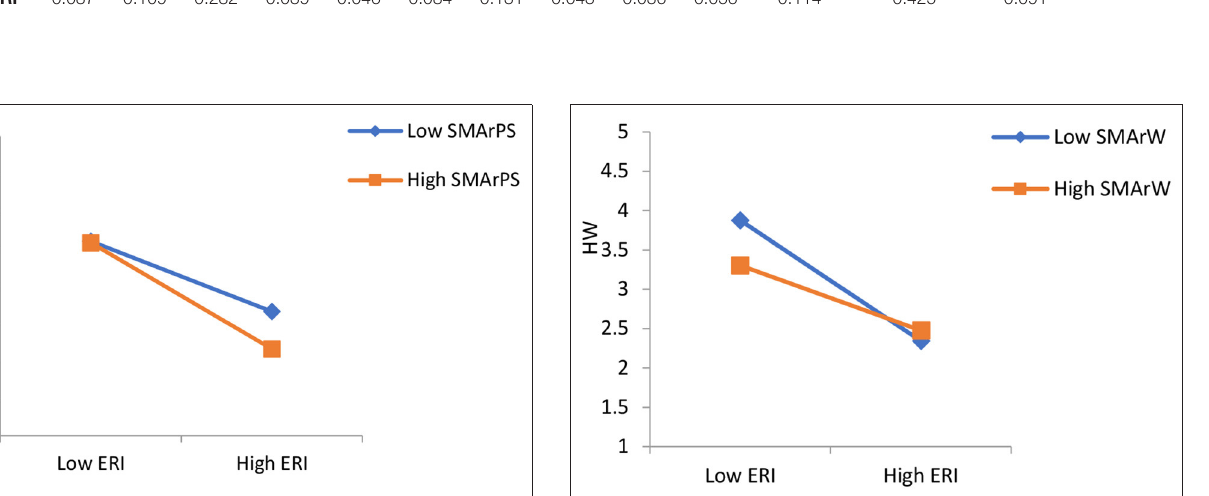
FIGURE 2 | The moderating effect of SMArPS on the relationship between ERI and HW.